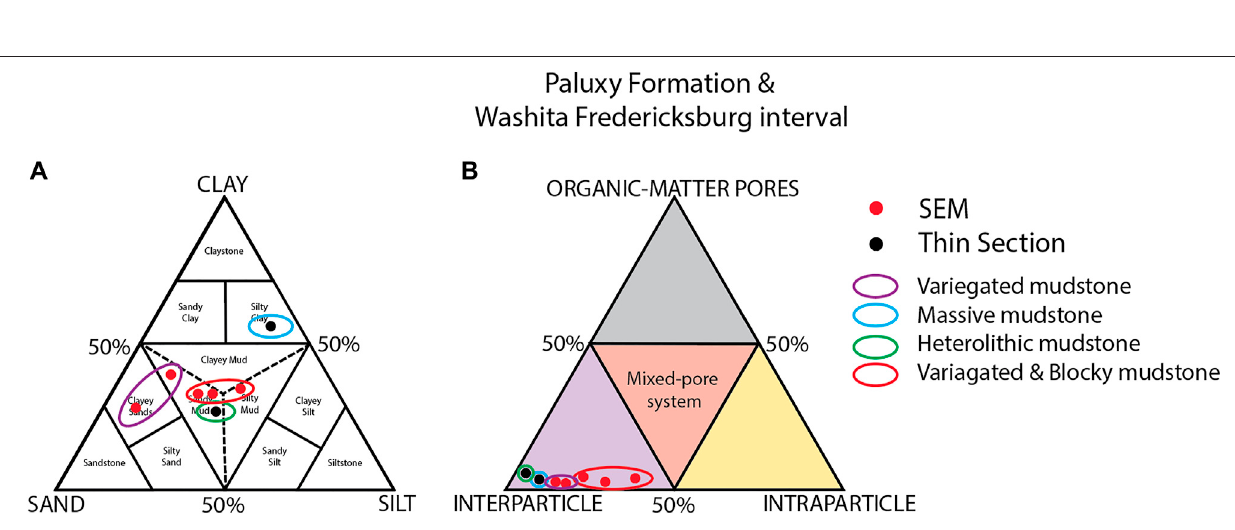
Frontiers in Energy Research |